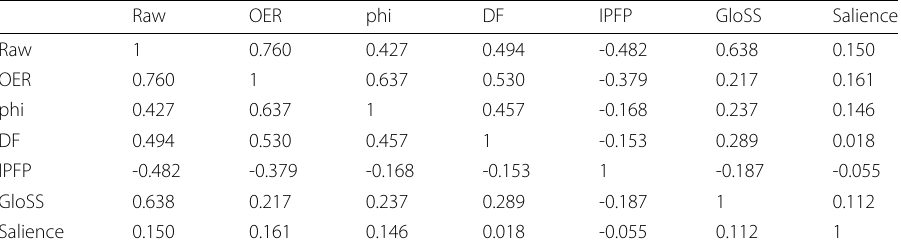
Table 14 Top 10 diseases with highest betweenness centrality Raw OER φ DF IPFP